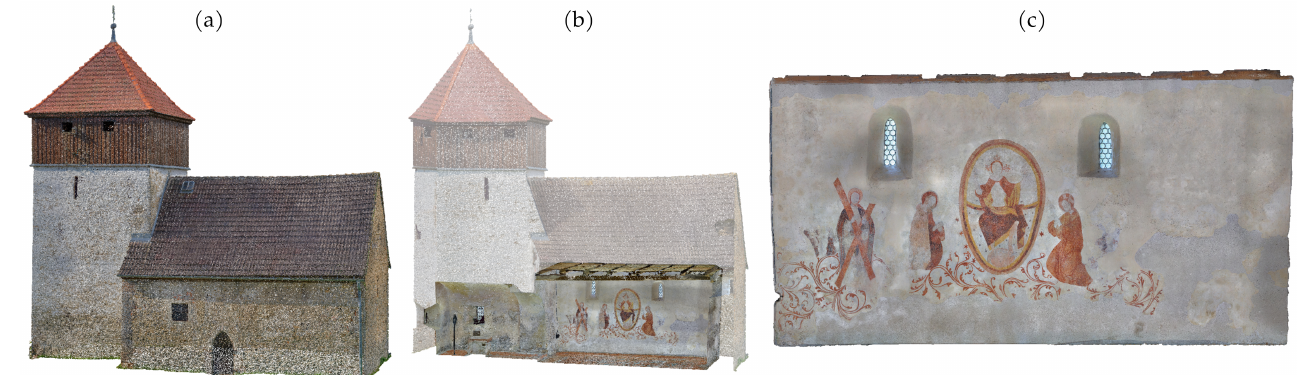
Figure 1. The captured point clouds of the Wehrkirche Döblitz ( a ) from outside and ( b ) of the main hall and the sanctuary at the ground level and ( c ) the reconstructed orthophoto of the wall